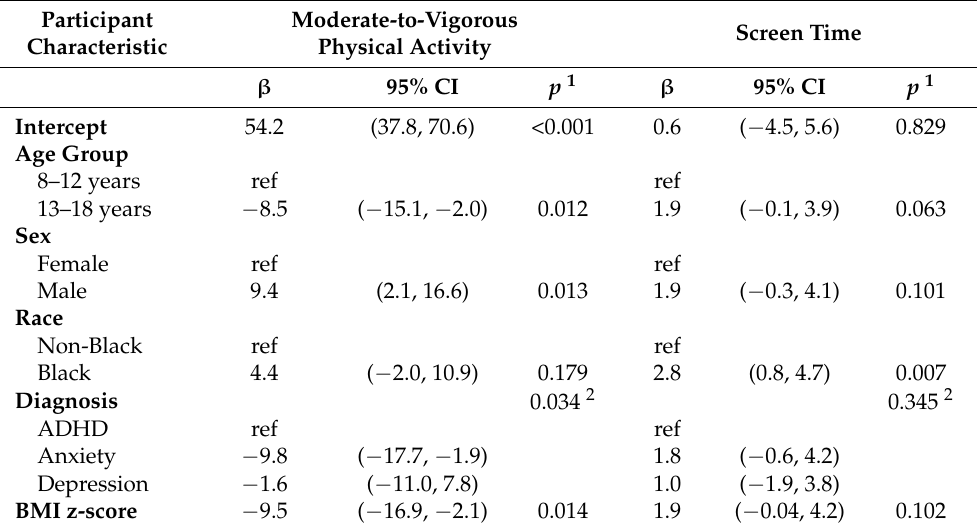
Figure 1. Physical activity and screen time by age group. Table 2. Association of physical activity and screen time with participant